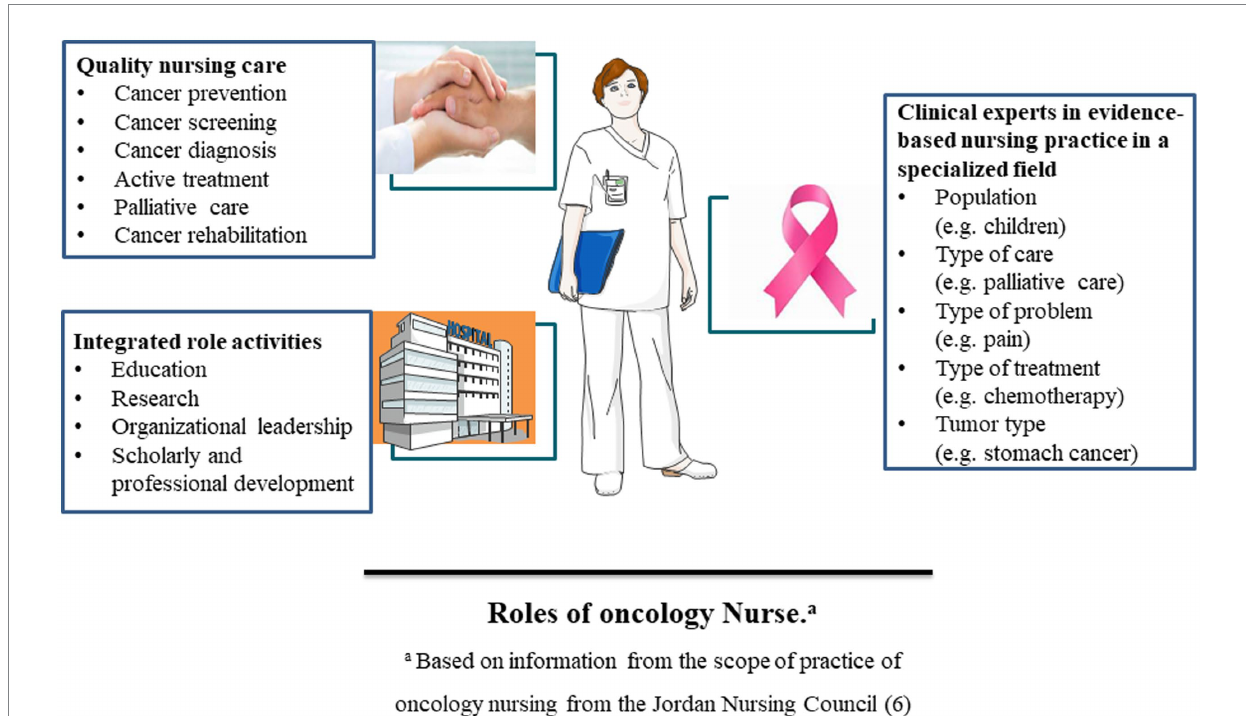
FIGURE 1 The oncology nurse’s role in quality nursing care, integrated role activities, and clinical experts in evidence-based nursing practice in a specialized